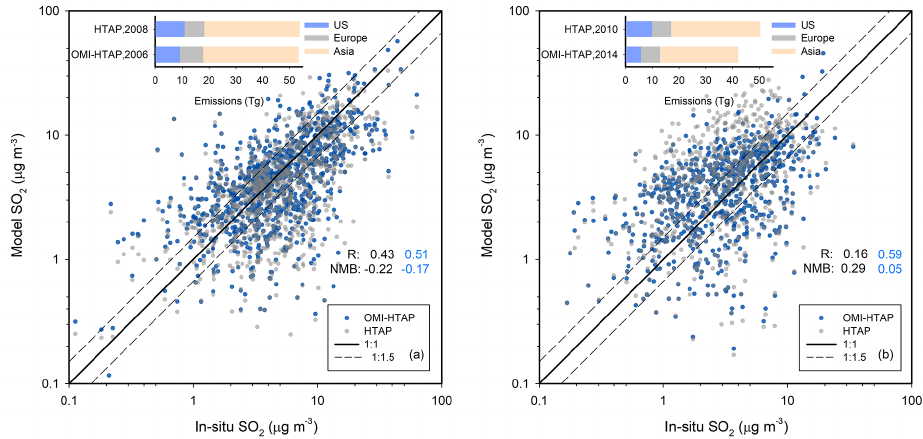
Figure 6. Comparison of modeled annual averaged SO 2 surface concentrations for in situ sites in 2006 (a) and 2014 (b) . The grey and blue dots denote values using the HTAP and the OMI-HTAP inventories for corresponding years, respectively. The inset plots compare emissions from two inventories by region. Note that Europe only includes European countries with AirBase sites and Asia only includes East and Southeast Asia in the plot. The values of correlation coefficient ( R ) and normalized mean bias (NMB) are color coded by black and blue for grey and blue dots, respectively. Note that the plots use logarithmic scales, but R and NMB are calculated based on original